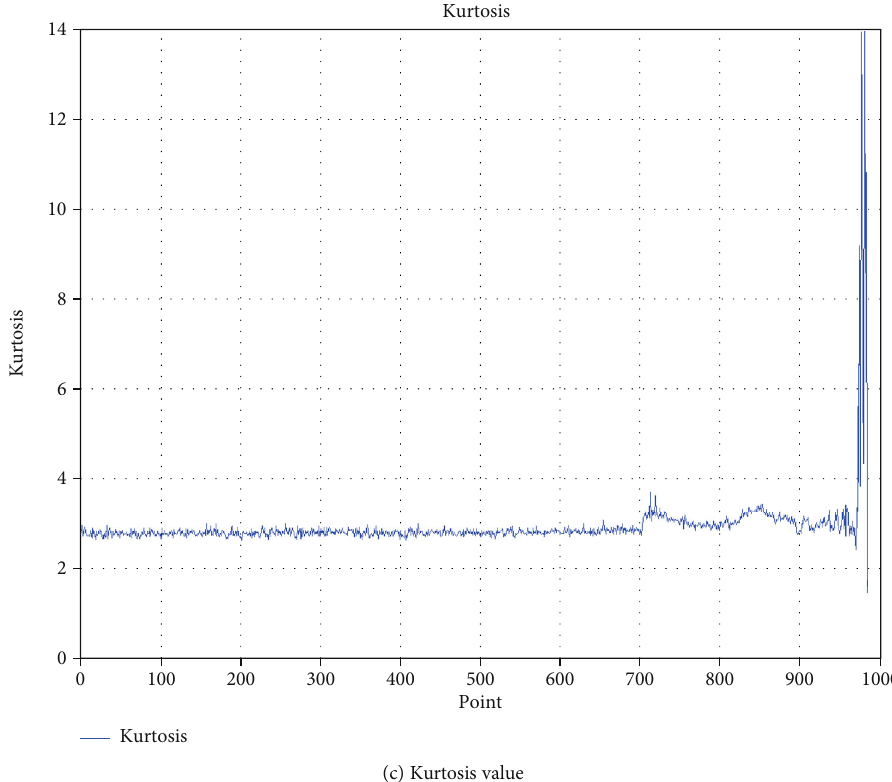
Figure 4: The calculation results of mean value, root mean square, and kurtosis